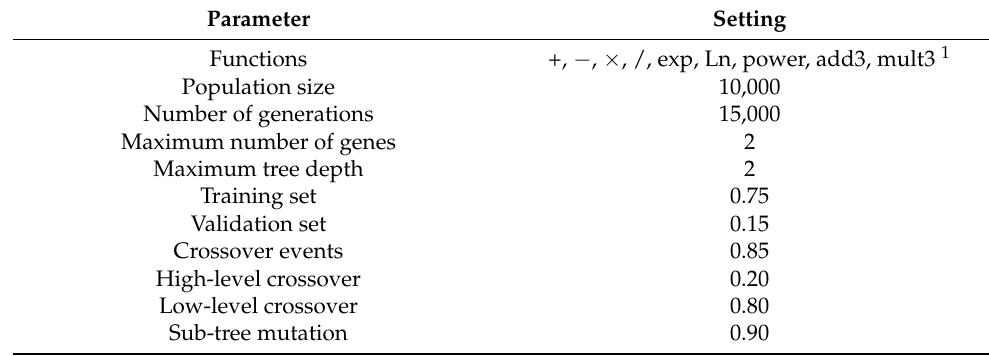
Table 2. The optimum parameters of the MOGP models of this